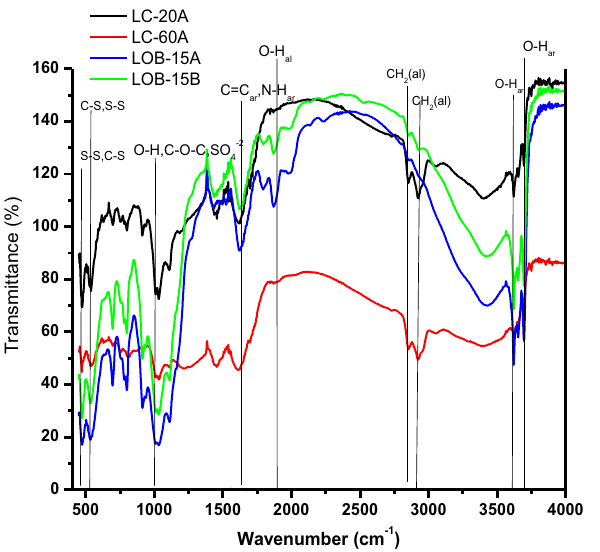
Fig. 31 FT-IR spectra for the leached coal and OB of the Ledo colliery